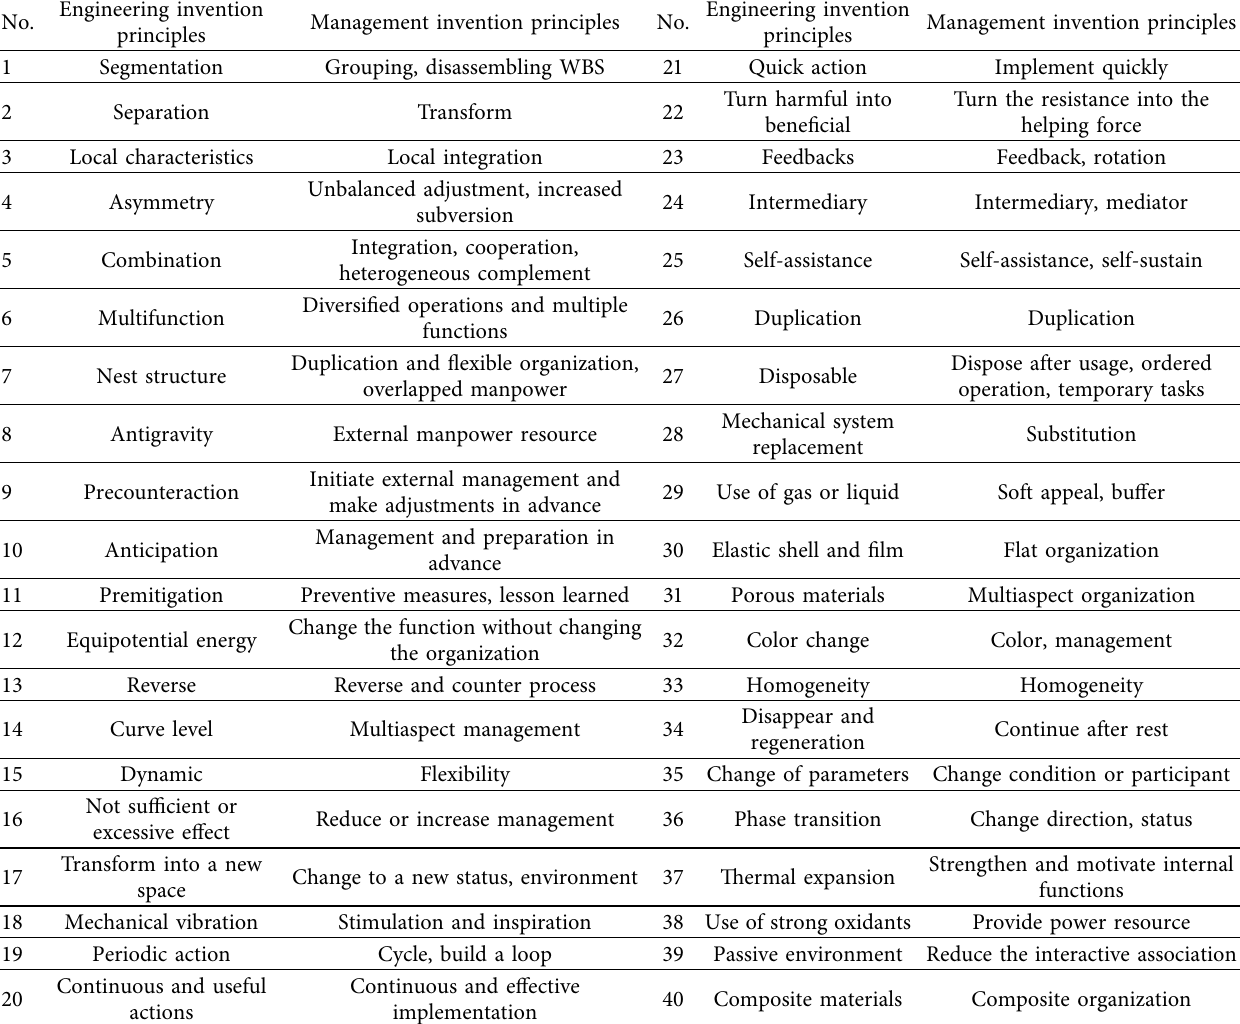
Table 9: Modification table of interface problem solution